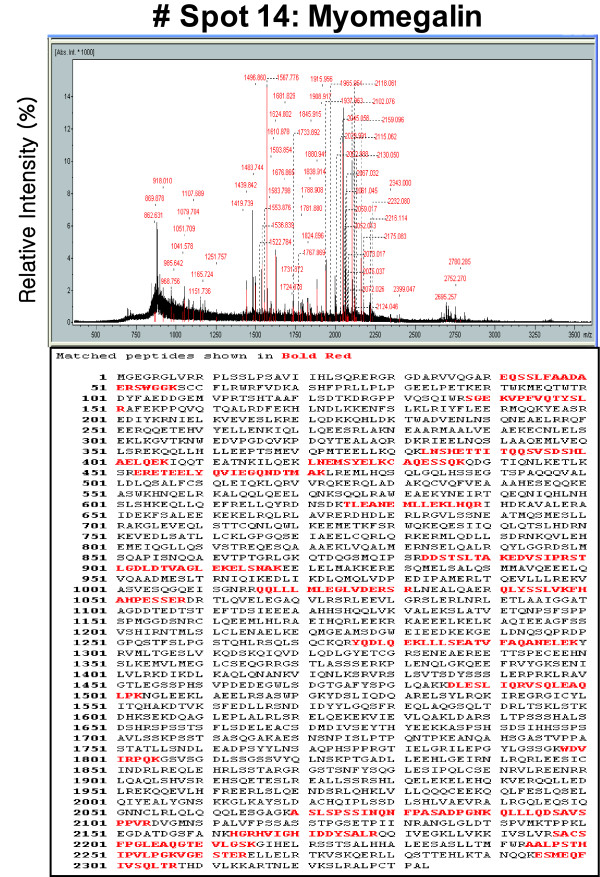
MALDI-TOF MS peptide mass fingerprint spectrum of spot No. 14 (gi|114558492). The protein corresponding to spot No. 14 in Figure 2 was extracted from the 2-D gel and analyzed by MALDI-TOF MS to determine its identity.